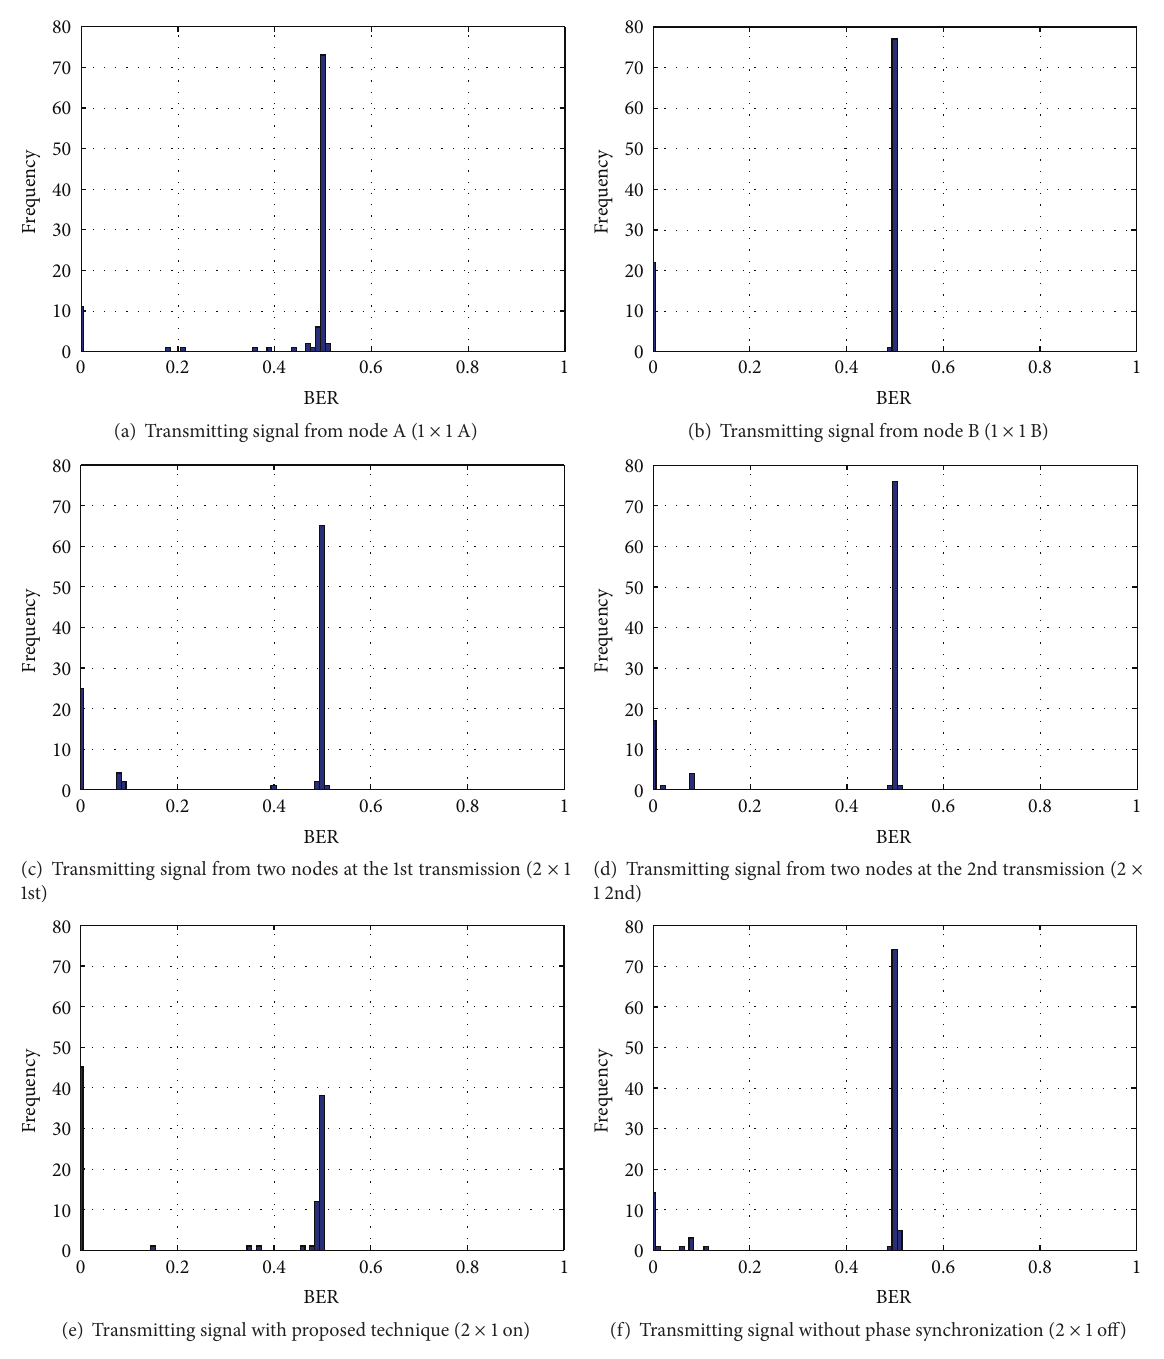
Figure 17: A histogram of Bit Error